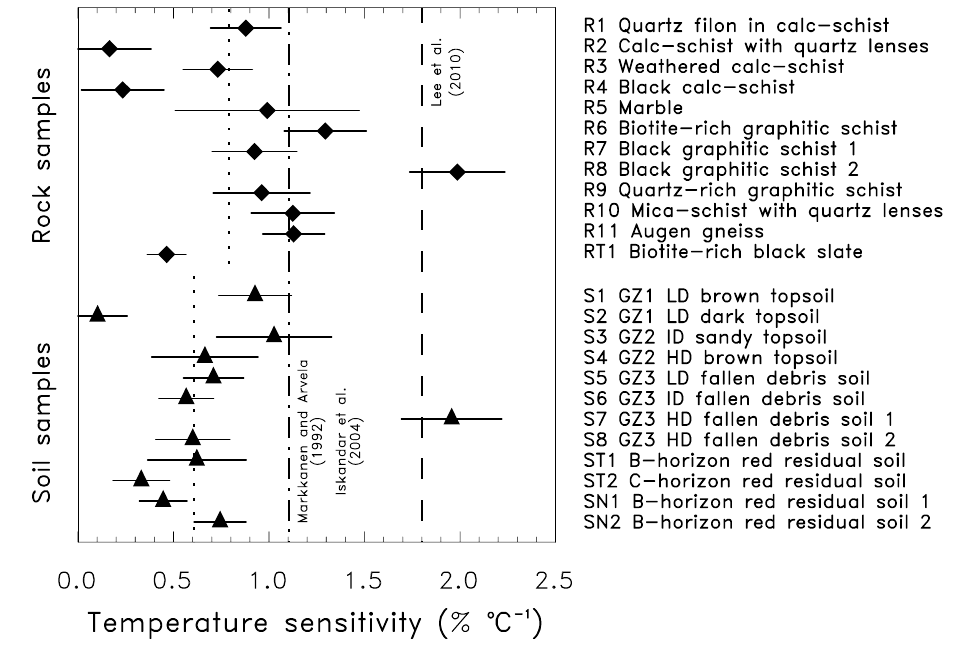
Fig. 6. TS of EC Ra from the whole data set of rock samples (diamonds) and soil samples (triangles). Error bars correspond to ± 1 σ (confidence level of 68%). Dotted lines represent the weighted average of the TS values, rock and soil samples separately. Values of TS derived from three previous studies (Markkanen and Arvela, 1992; Iskandar et al., 2004; Lee et al., 2010) are also plotted for comparison (dashed